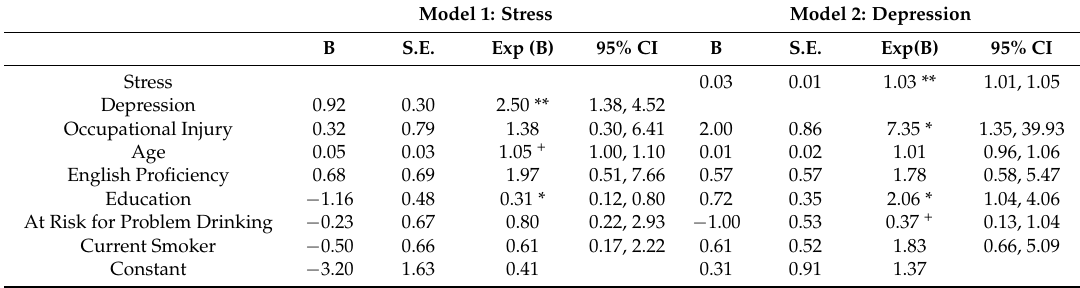
Table 3. Adjusted Odds Ratios and 95% Confidence Intervals (CIs) for Relationships Between Stress, Depression, and Occupational Injury Among Migrant Farmworkers in